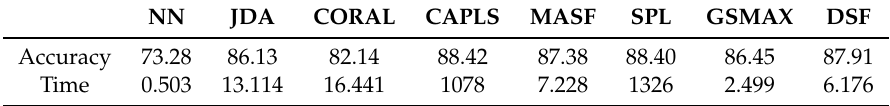
Table 3. An intuitive comparison of average performance (accuracy, %) and average running time (time, s). NN JDA CORAL CAPLS MASF SPL GSMAX DSF